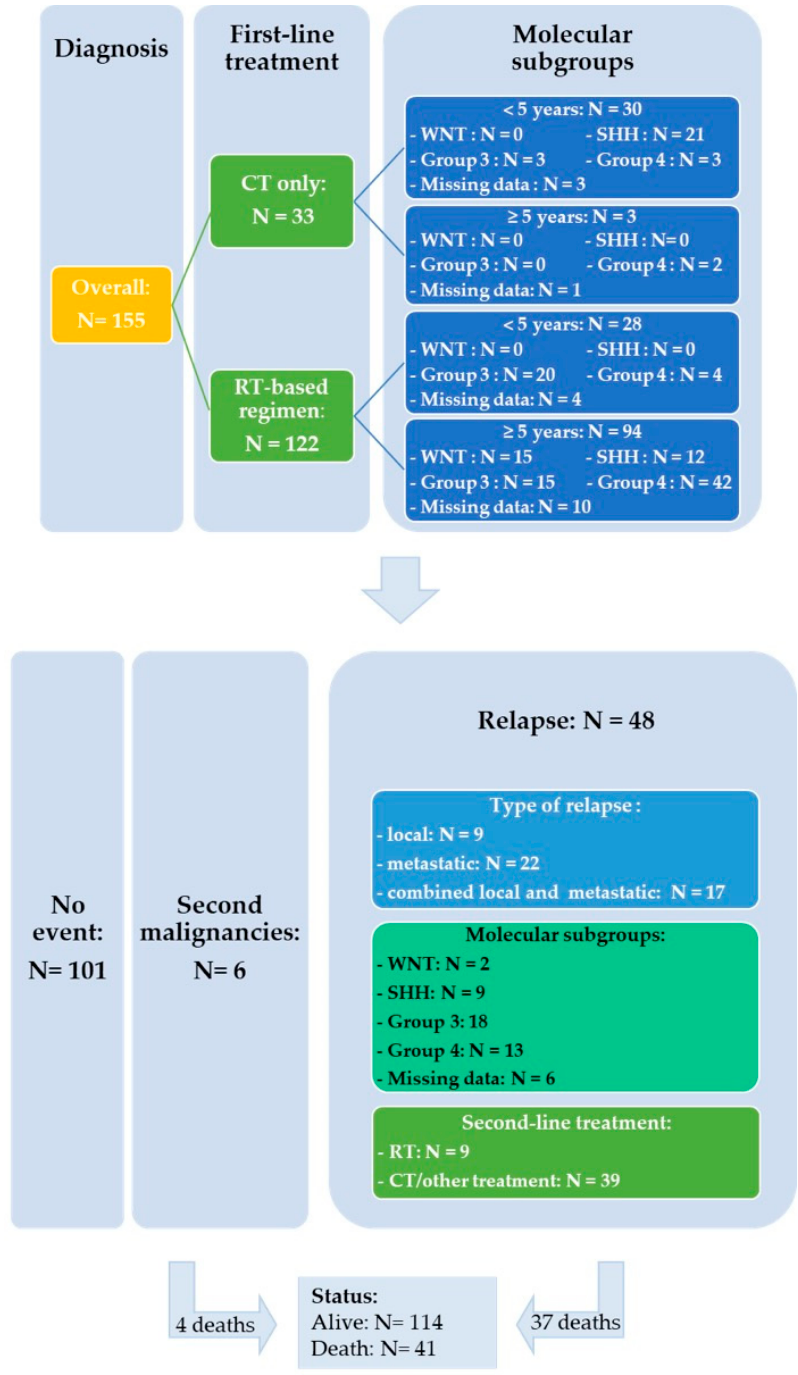
Figure 4. Flowchart of the entire study cohort. Figures 5 and 6 represent upfront treatment according to DNA-methylation subgroups in patients with relapsed medulloblastoma (Figure 5) and treatment at relapse according to DNA-methylation subgroups in patients with relapsed medulloblastoma after receiving upfront radiotherapy-containing regimen and chemotherapy only (Figure 6).